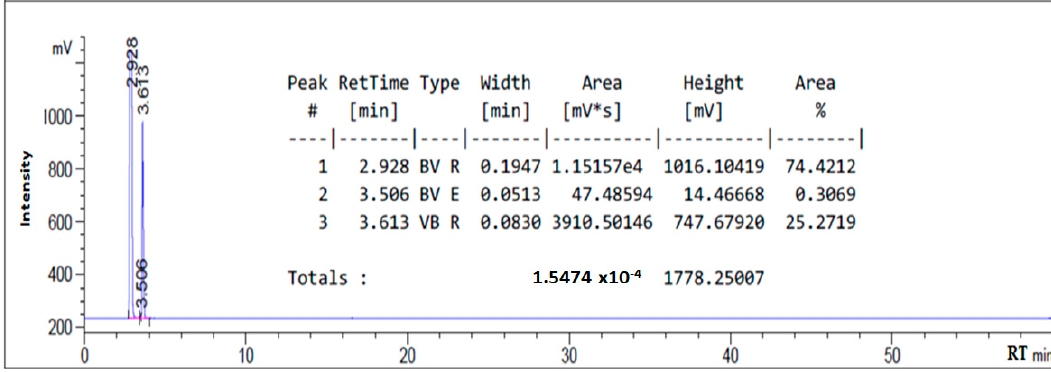
Figure A4. HPLC chromatogram for 0.5 wt.% sodium chloroacetate.